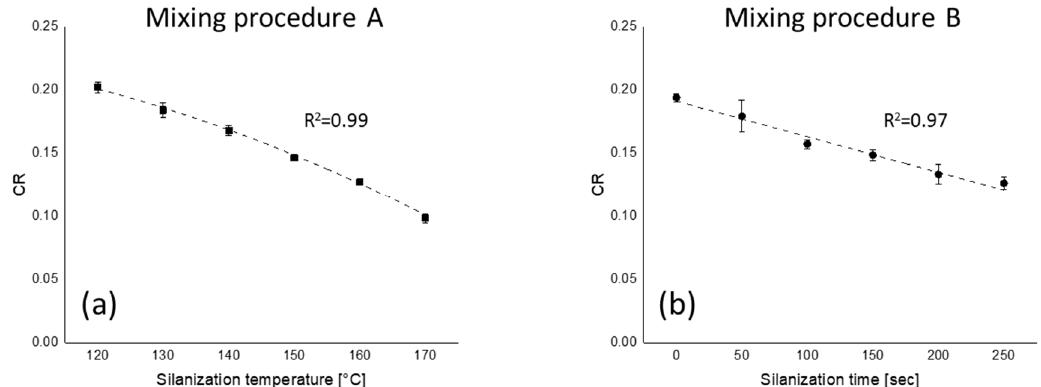
Figure 8. Coupling rate (CR) as a function of ( a ) silanization temperature and ( b ) silanization time; fitting lines for ( a ) and ( b ) are based on polynomial and linear fit with maximum R 2 , respectively.